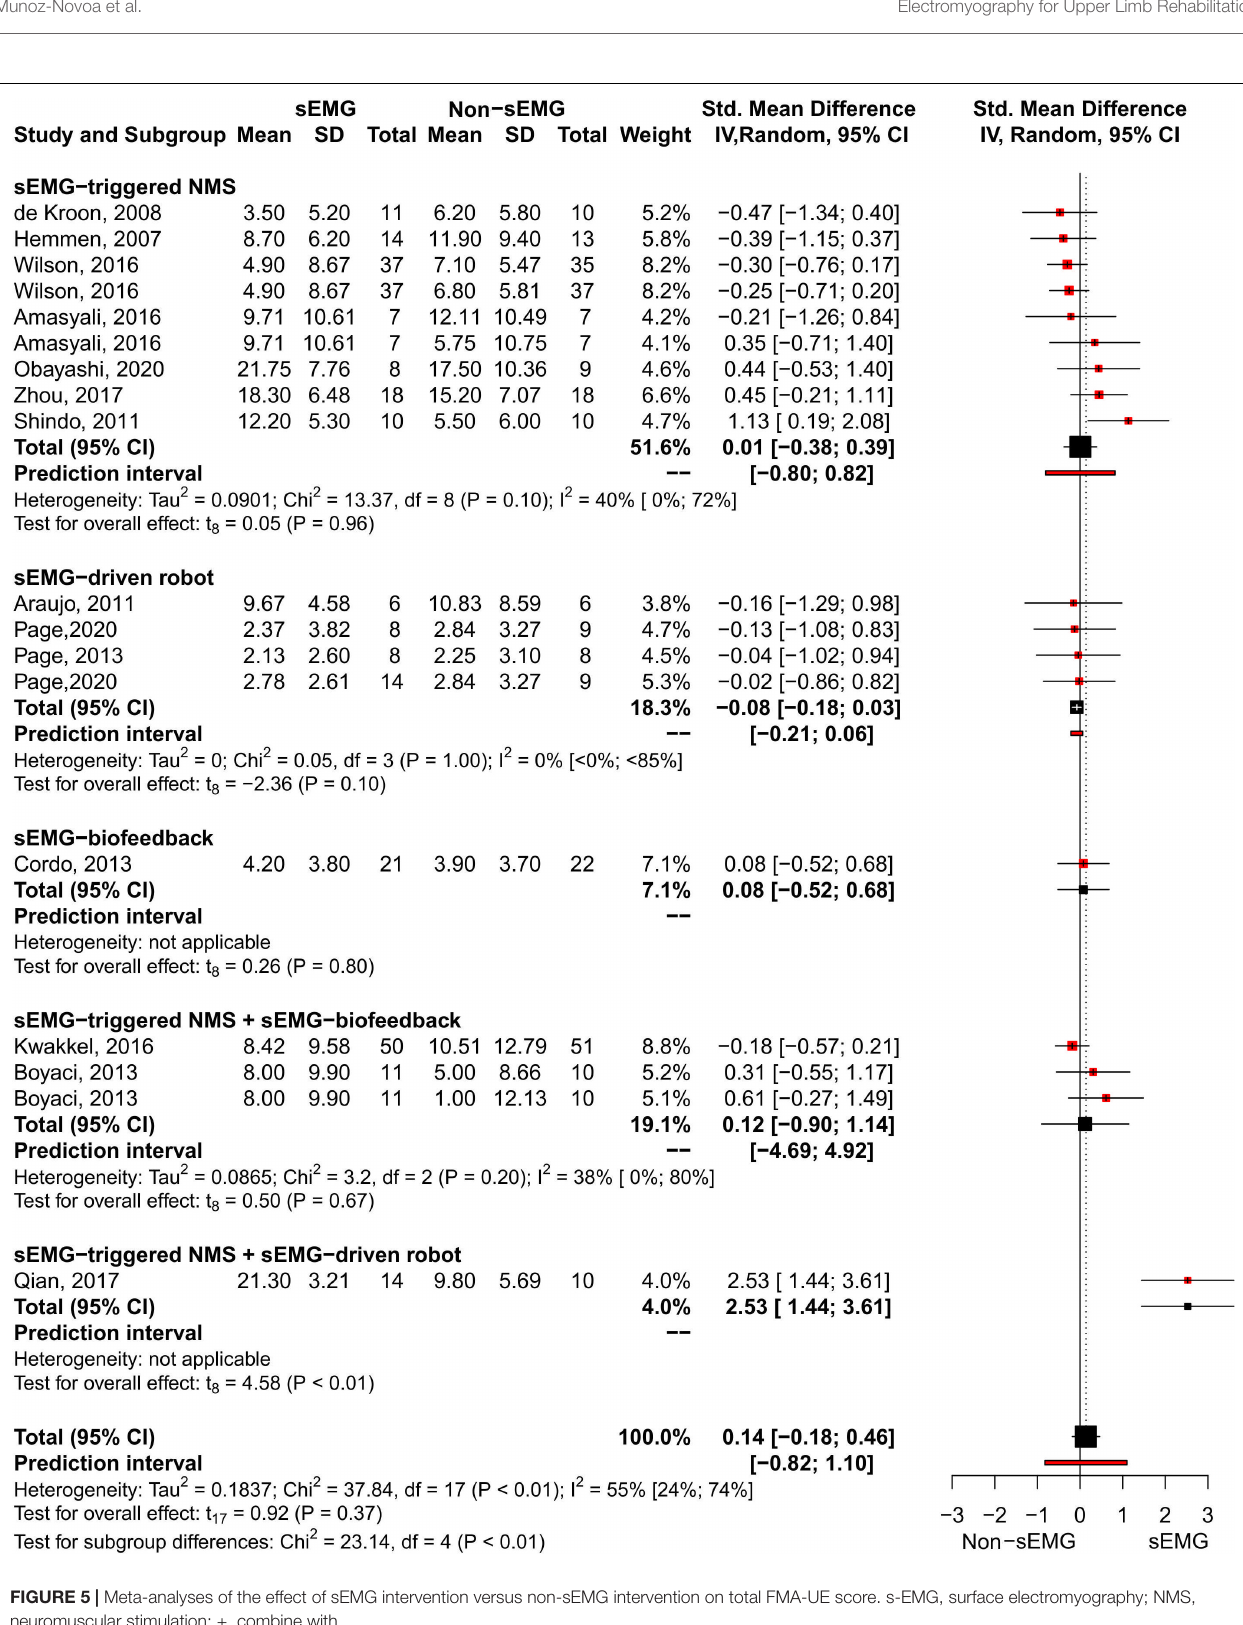
Frontiers in Human Neuroscience |